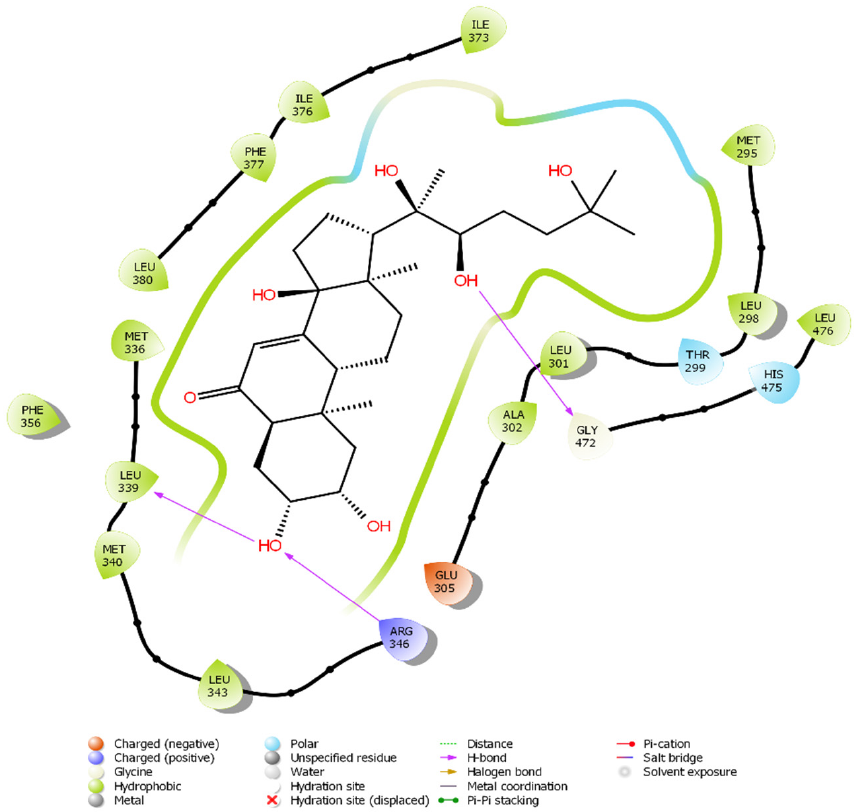
Figure 4. The binding poses of 20-HE in the binding site of ER β . Hydrogen bonds are noted with Leu339, Arg346 and Gly472 (yellow dashed lines). A single clash at 2.75 Å is found with Gly472 (red dashed line).